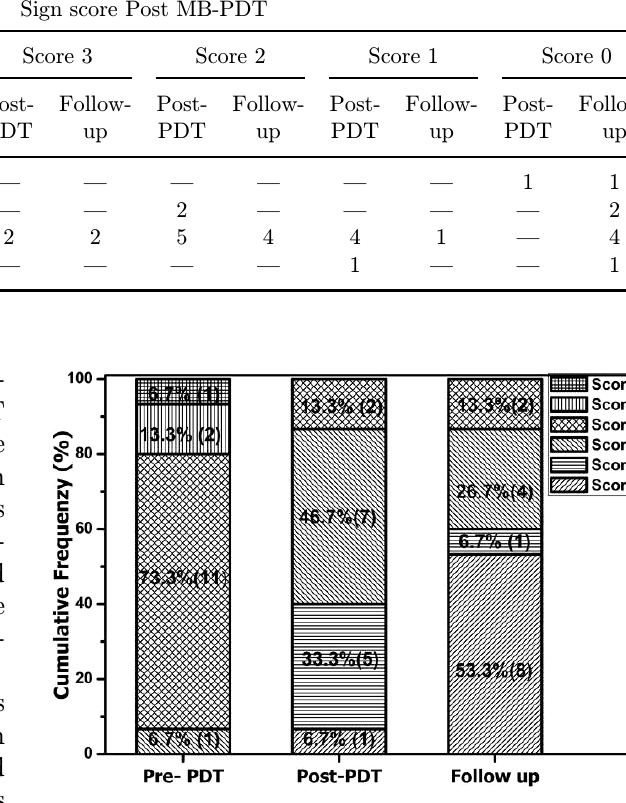
Fig. 2. Frequency of sign score for OLP lesions on pre-, post- PDT and follow-up conditions (number of lesions).